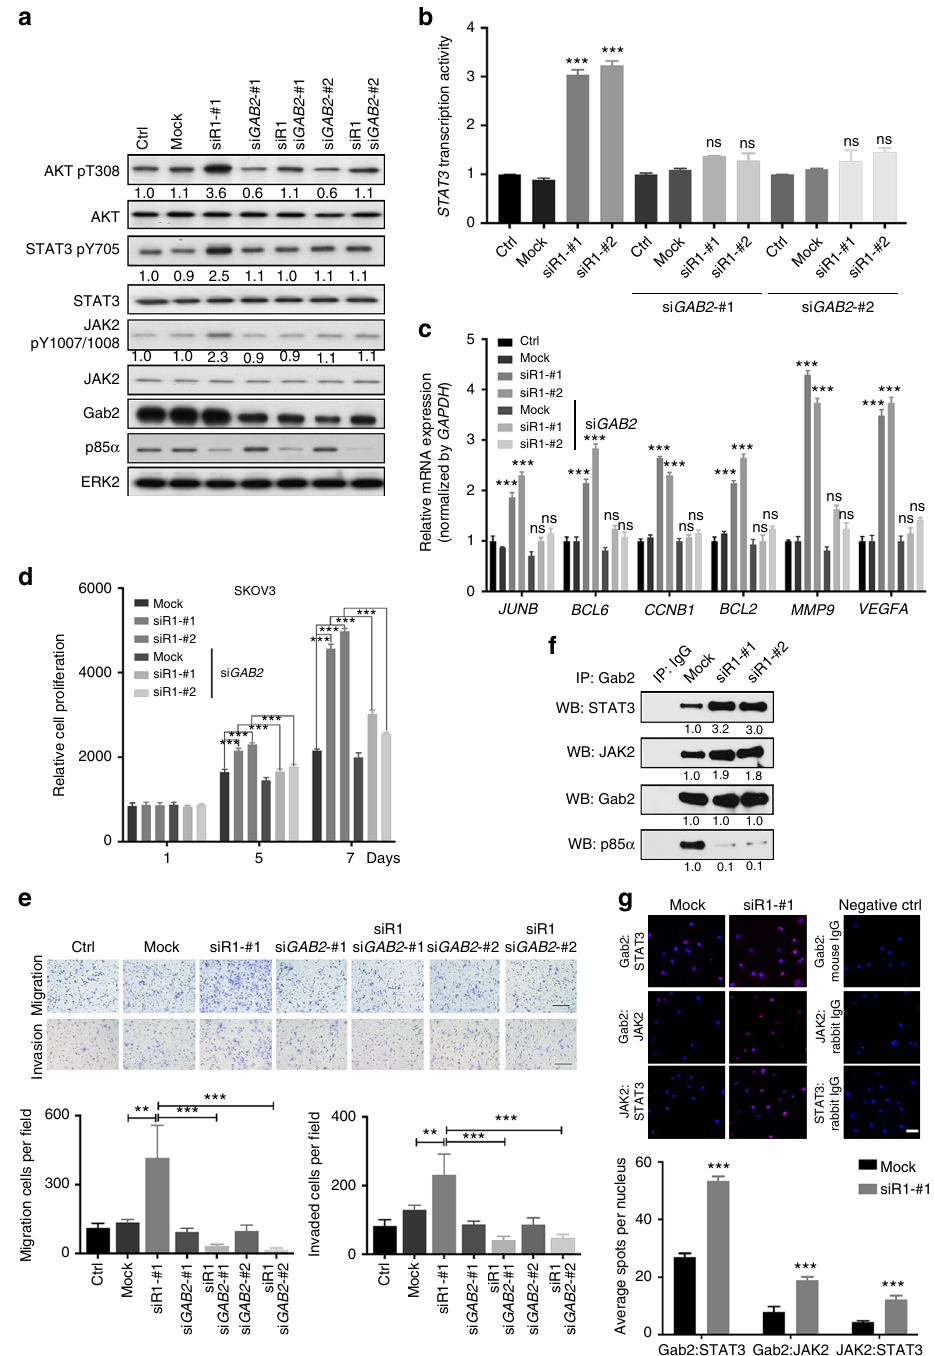
Fig. 3 Gab2 is required in PIK3R1 loss-induced signaling and oncogenic phenotypes. a Total cell lysate of SKOV3 cells transfected with either PIK3R1 siRNA, GAB2 siRNA or in combination for 72 h were harvested for western blotting. b SKOV3 cells were transfected with PIK3R1 siRNA or co-transfected with GAB2 siRNA. After 24 h, cells were transfected with 4xM67 pTATA TK-Luc (containing STAT3-binding site) with Renilla luciferase vector for another 24 h. Dual-luciferase reporter assay was performed. c Total RNA of SKOV3 cell transfected with PIK3R1 siRNA or in combination with GAB2 siRNA for 72 h were harvested for real-time PCR. d SKOV3 cells were transfected with PIK3R1 siRNA or co-transfected with GAB2 siRNA, cell viability was measured over 7 days. e Representative images of migrated or invaded SKOV3 cells (upper) and means with SD of migrated or invaded cells of fi ve fi elds at magni fi cation of 100 × (lower). Scale bar, 200 μ m. f Total lysates of transfected SKOV3 cells were immunoprecipitated with Gab2 antibody prior to western blotting. g SKOV3 cells were transfected with PIK3R1 siRNA prior to proximity ligation assay with the indicated pairs of antibodies. Representative images are presented (upper) with numbers of averaged spots per nucleus (lower). Scale bar, 50 μ m. The numbers below the blots represent the mean values from densitometry readings of three independent experiments. Error bars represent SD. ** p < 0.005; *** p < 0.001; ns, no signi fi cant difference compared